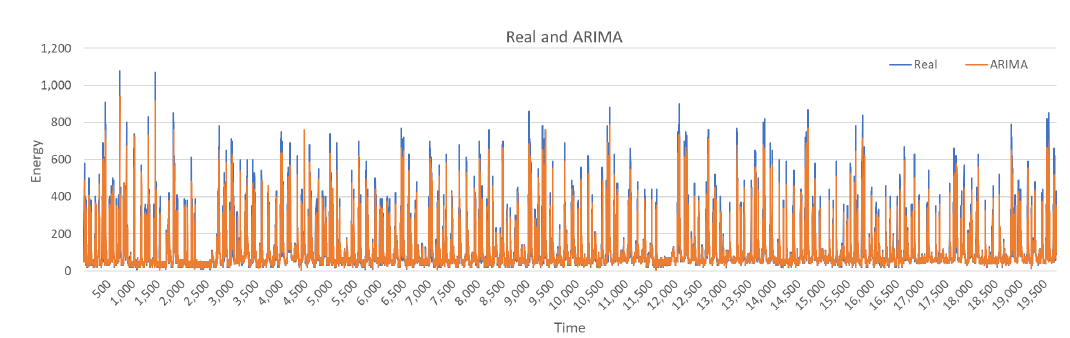
Figure 7. Auto Regressive Integrated Moving Average (ARIMA) fitted model (UCI data